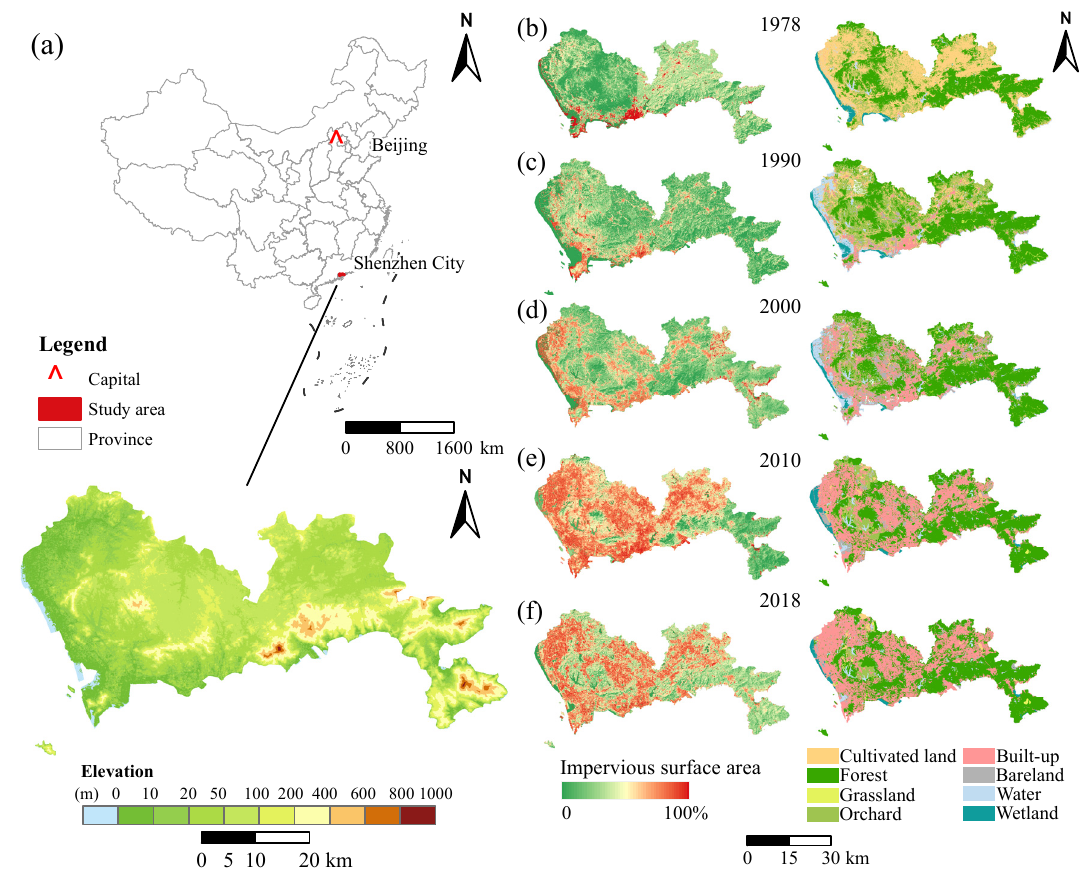
Figure 1. The location of the study area. Left : ( a ) Shenzhen city. Right : ( b–f ) Impervious surface area (ISA) and land use for 1978, 1990, 2000, 2010, and 2018, respectively. Table 1. Data sources and